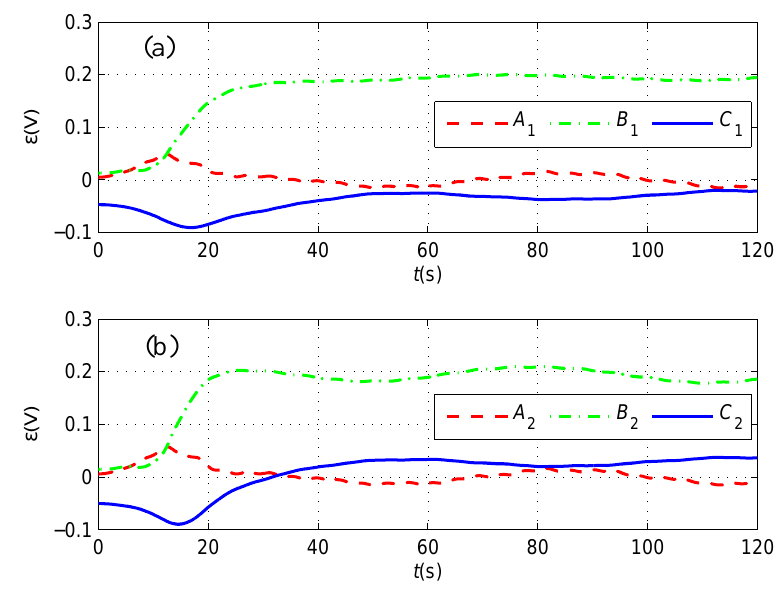
Figure 15. ( a ) The induced electromotive forces measured by the port tri-axial magnetometer; and ( b ) The induced electromotive forces measured by the starboard tri-axial magnetometer in the case of k ε = 1. The red dashed line, the green dash dotted line and the blue line represent the force components along the x -axis, y -axis and z -axis of the tri-axial magnetometer, respectively.